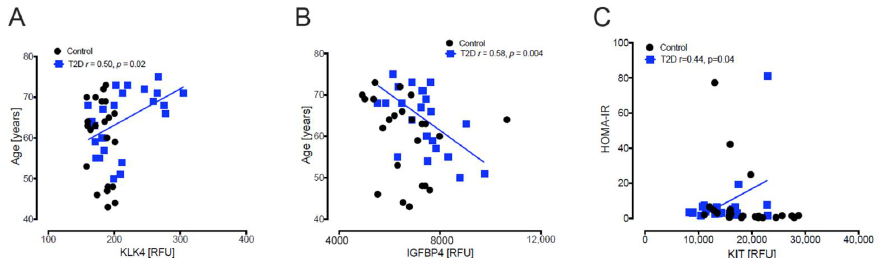
Figure 3. Correlation analyses of proteins. For age, there was a positive correlation with Kallikrein- 4 (KLK4) ( A ) and a negative correlation with Insulin-like growth factor-binding protein-4 (IGFBP4) ( B ) in T2D (blue squares). No correlations were observed with age in controls (black circle). For HOMA-IR, there was a positive correlation with Mast/stem cell growth factor receptor-Kit (KIT) ( C ) in T2D.